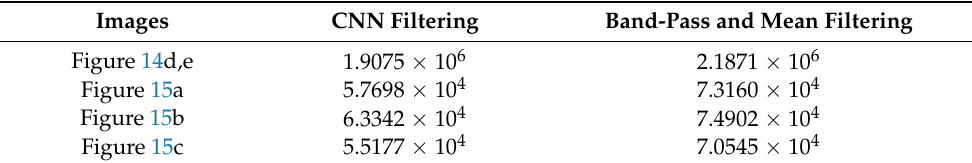
Table 1. Image entropy comparison of the filtering results.